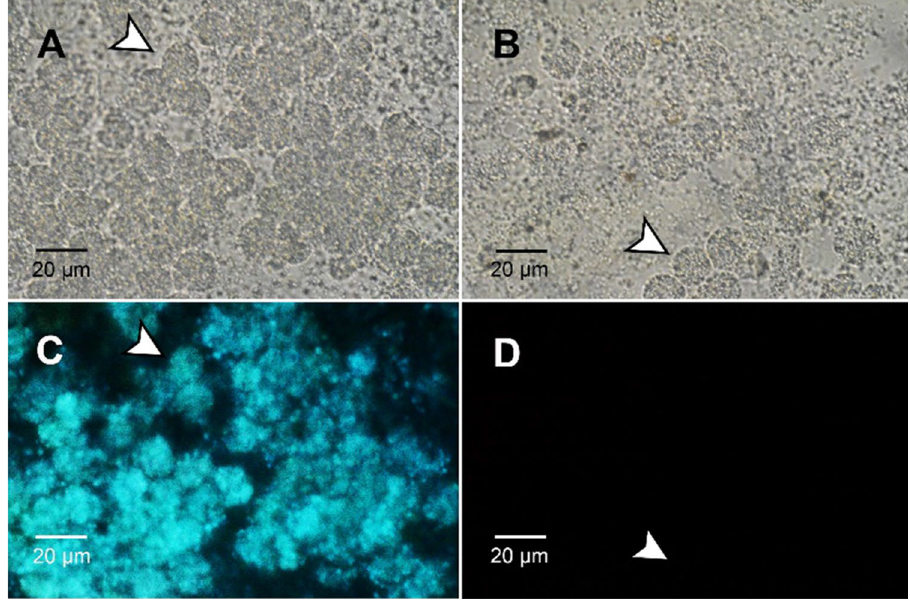
Figure 3. ( A ) Bright field image of P. litoralis coelomic cells (arrowheads). ( B ) Bright field image of P. longissimus coelomic cells. ( C ) P. litoralis coelomic cells under UV irradiation at 380 nm. ( D ) P. longissimus coelomic cells under UV irradiation at 380 nm. The photography conditions in ( C ) were the same as those in ( D ), but no fluorescence was observed in the latter